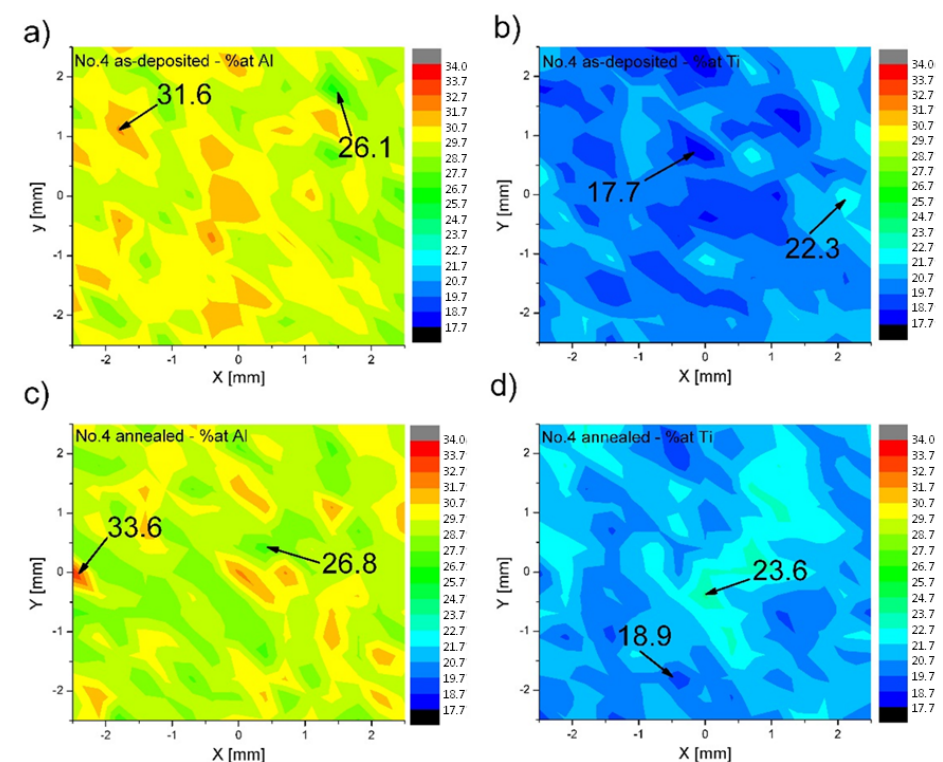
Figure 3. XRF macro-maps showing the distributions of Al and Ti in sample no. 4